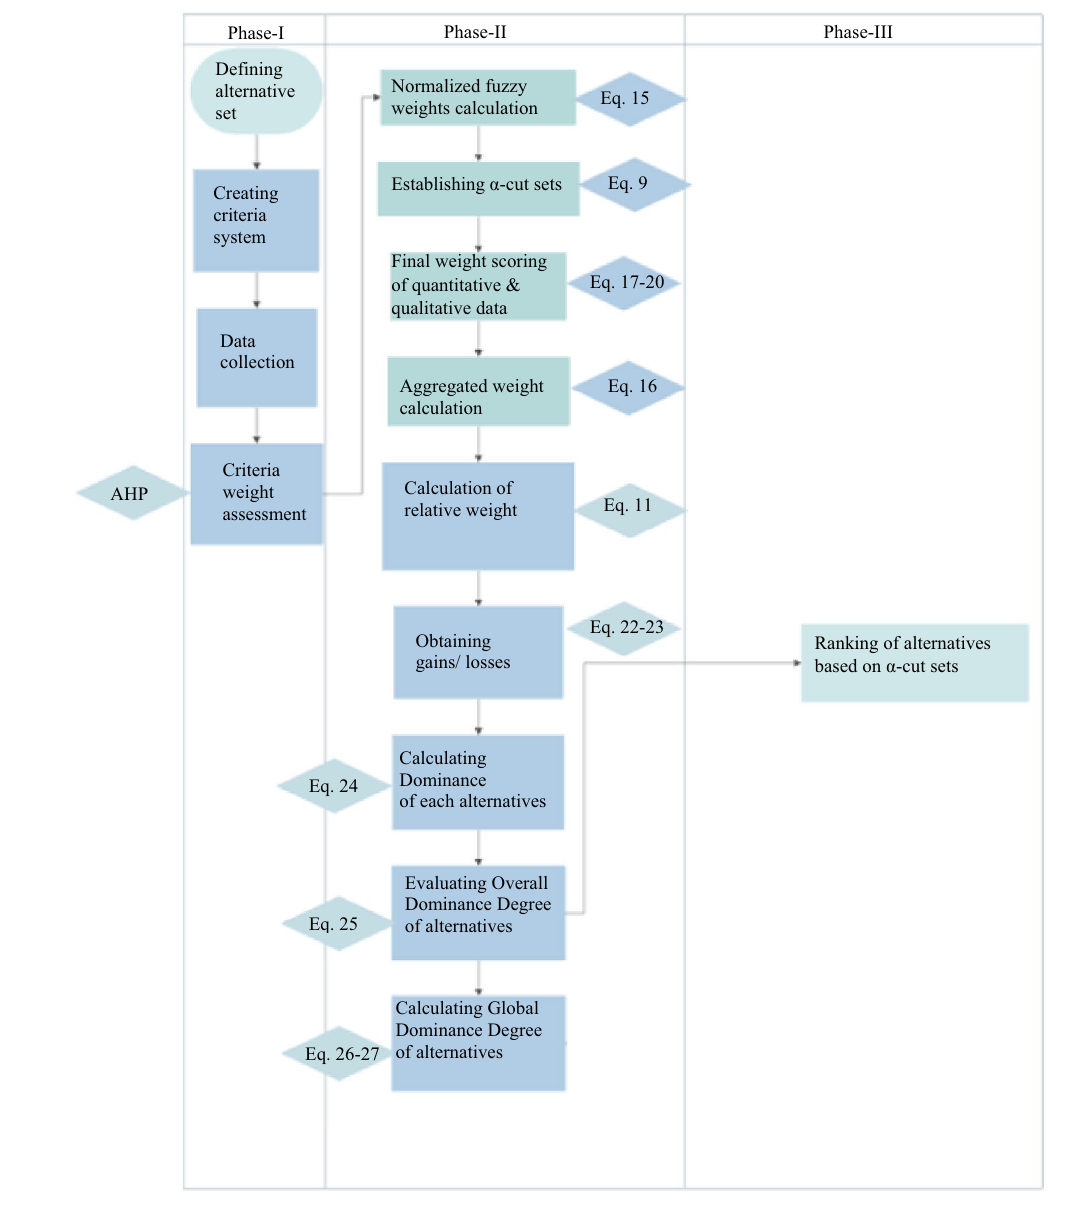
Figure 4. Decision making process in this